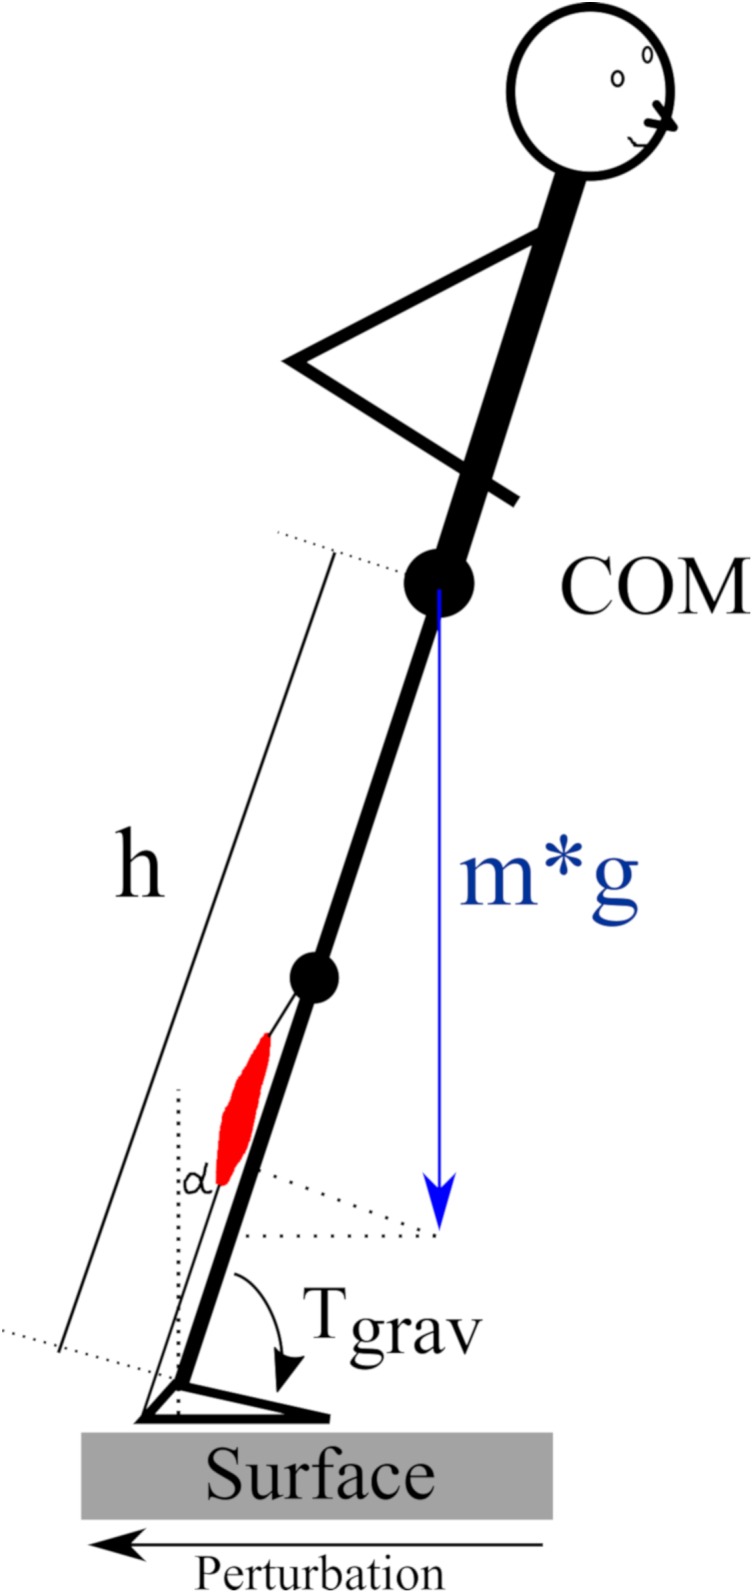
Schematic of the gravity-dependency of the human body in the sagittal plane according to the inverted pendulum model published by van der Kooij et al. (2005) and Bottaro et al. (2008). The pendulum is inclined in the anterior direction due to a translational posterior surface perturbation. The required muscle force of the plantarflexors (red) for a repositioning of the center of mass (COM) above the base of support depends on the body mass (m), the COM height (h) above the ankle joint and the inclination angle alpha (α) with reference to the vertical. The gravity-dependent ankle joint torque Tgrav = m∗g∗h∗sin(α).